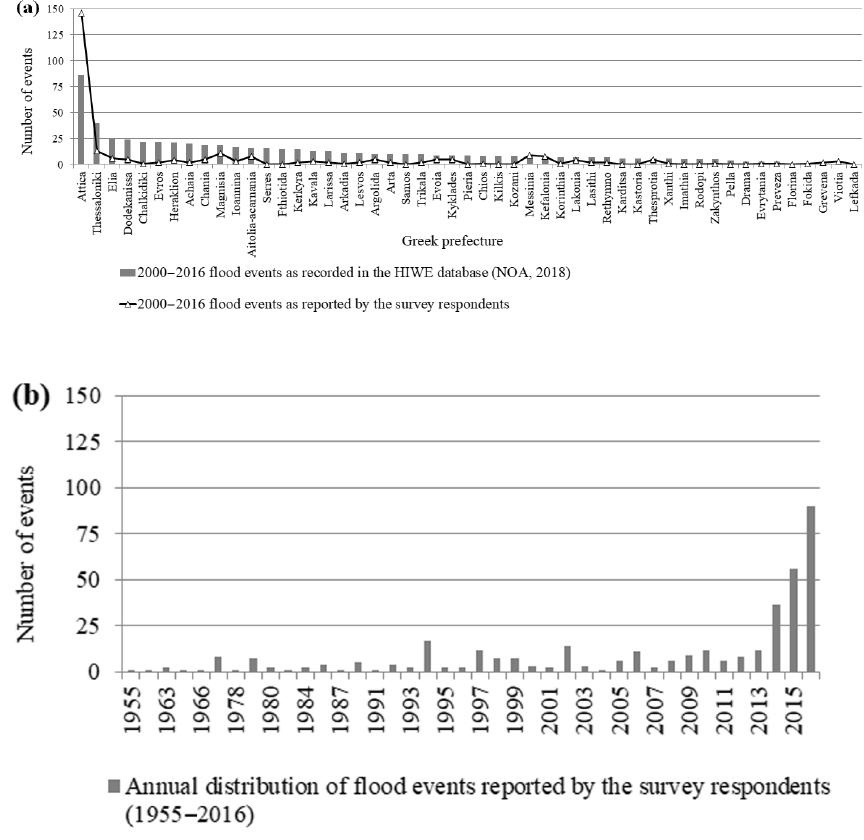
Figure 2. (a) Number of flood events per Greek prefecture in the period 2000–2016, as recorded in the HIWE database (NOA, 2019; Papagiannaki et al., 2013) and the survey. (b) Annual distribution of the survey flood reports (1955–2016). Table 3. Current preparedness: items, adjusted weights, and model